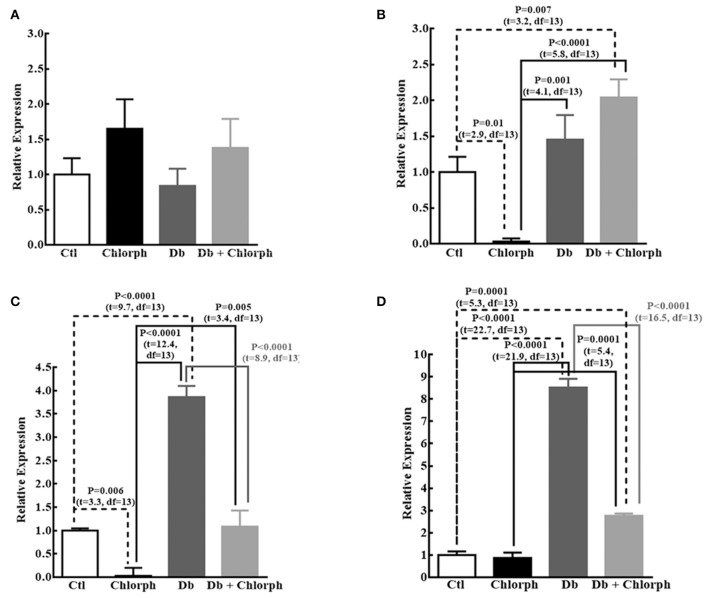
Chlorpheniramine prevents the increased expression of neuronal factors at E14. (A–D) Graphs of the expression of Prox1 (A), Ngn1 (B), βIII-Tub (C), and MAP2 (D) in telencephalic tissue at E14 from control (Ctl), chlorpheniramine (Chlorph), diabetic (Db) and Db+Chlorph groups. The results are the relative expression to the control (S.E.M.) using the 2−ΔΔCT method from five (Ctl) or four (Chlorph, Dd and Db+Chlorph) independent experiments per triplicate. One-way ANOVA was performed [A, F(3, 13) = 1.2, P = 0.34, and R2 = 0.22; B, F(3, 13) = 12.2, P = 0.0004, and R2 = 0.73; C, F(3, 13) = 57, P < 0.0001, and R2 = 0.93 and D, F(3, 13) = 218.2, P < 0.0001, and R2 = 0.98], followed by Fisher's LDS multiple comparison test, and significant P values are shown in each graph.